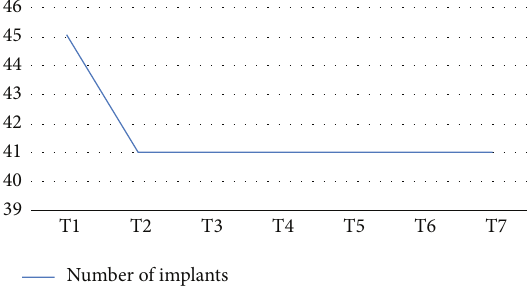
Figure 6: Implant survival